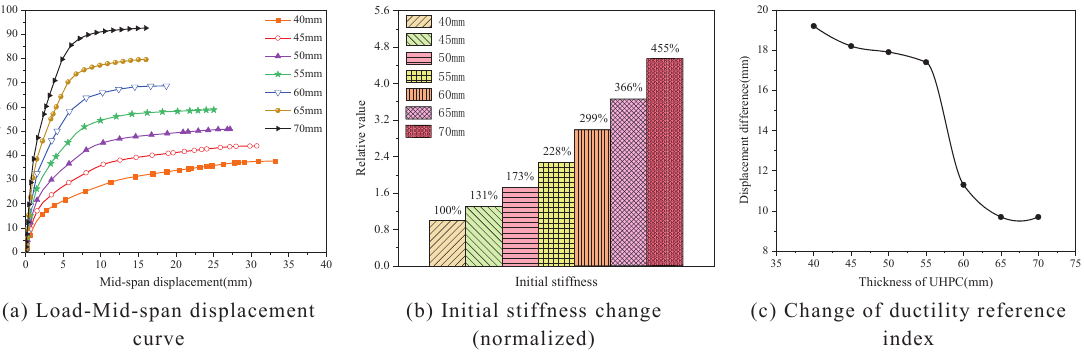
Figure 15. Influence rule of variable UHPC layer thickness on composite board: ( a ) load-mid-span displacement curve, ( b ) Initial stiffness change (normalized), ( c ) Change of ductility reference